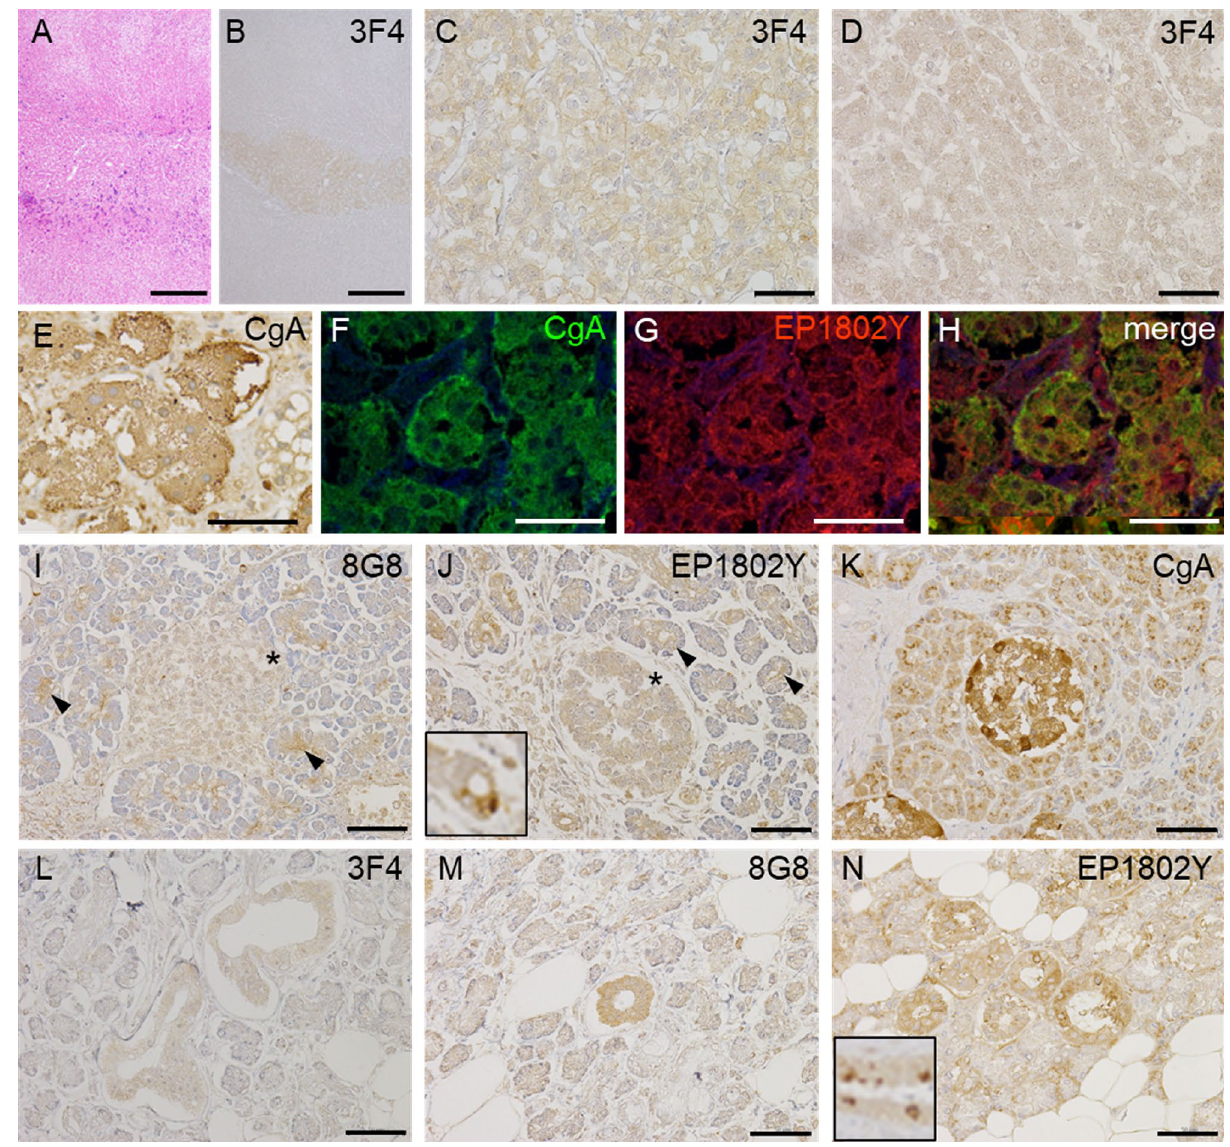
Figure 6. Histological and immunohistochemical findings in the endocrine and exocrine tissues ( A – H : adrenal gland, I – K : pancreas, L – N : submandibular gland). ( A ) Hematoxylin and eosin staining show a normal appearance of the adrenal gland (case 6). ( B , C ) Immunohistochemistry for prion proteins (PrPs) (3F4) shows PrP immunopositivity in the adrenal medulla. ( D ) PrP immunopositivity (3F4) is very weak in the zona reticularis of the adrenal gland. ( E ) Immunohistochemistry for chromogranin A (CgA) shows CgA immunopositivity in the adrenal medulla. ( F – H ) Double immunofluorescence of CgA and PrP (EP1802Y) shows colocalization of CgA and PrP in the adrenal medulla. ( I , J ) Immunohistochemistry for PrP ( I : 8G8, J : EP1802Y) shows weak immunopositivity in the islets (asterisks) and ductal epithelial (arrowheads) cells.